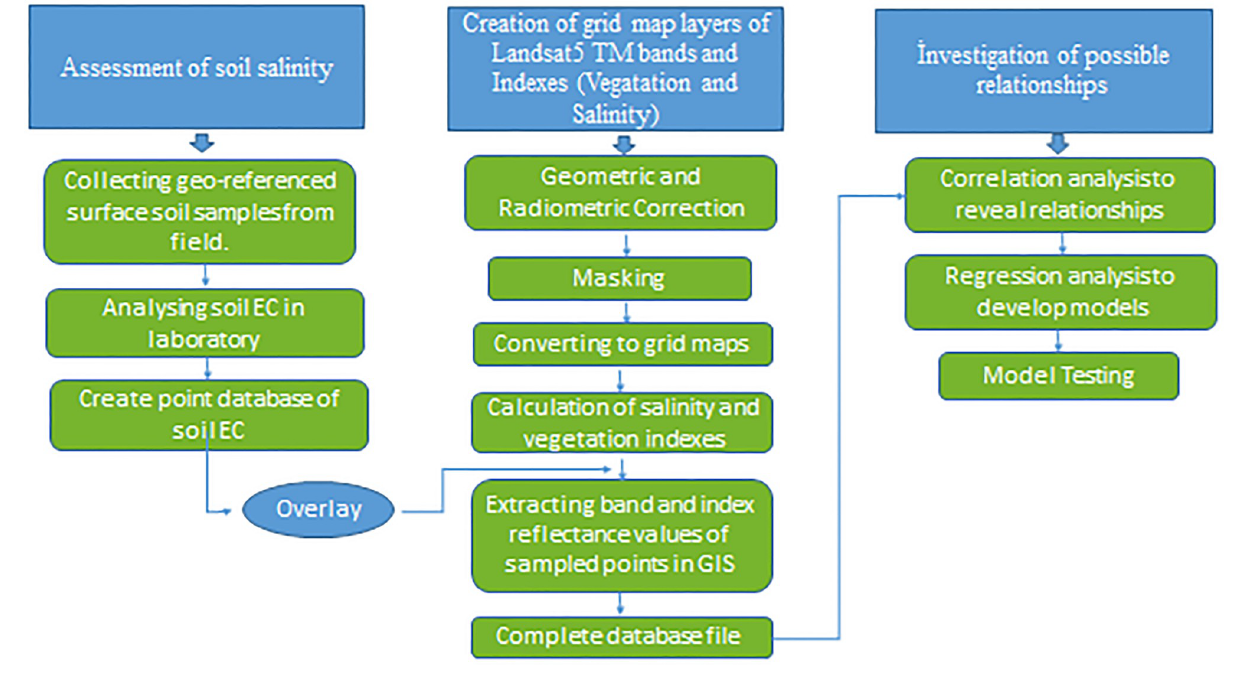
Fig 3. Flowchart of the applied